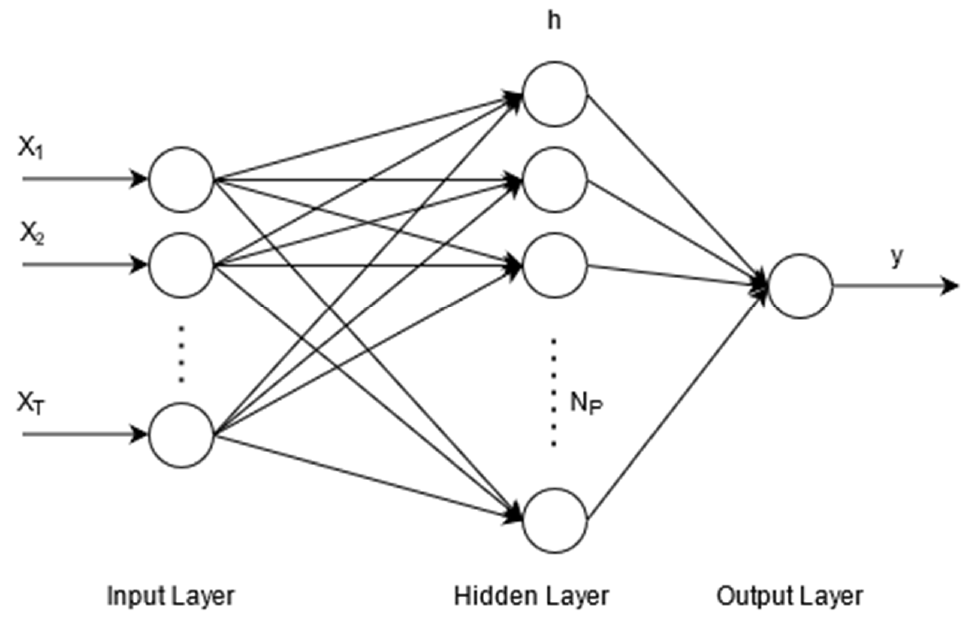
Figure 3. The proposed feed-forward neural network.